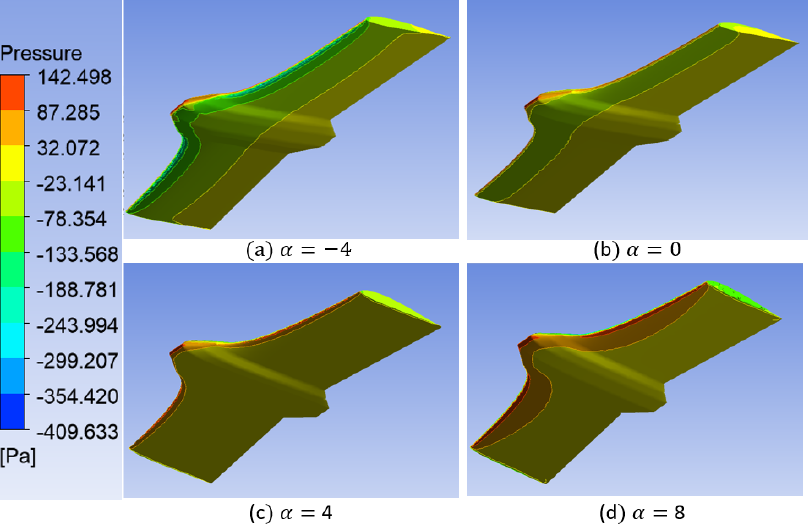
Figure 17. Pressure distribution on the tail-sitter surface at different angles of attack at lower surface. The inverse of the pressure behaviors around the tail-sitter area is observed in Figure 18a–c for the velocity distributions. When the aircraft is tilted downwards, the airflow is intercepted by the upper surface (extrados), causing a decrease in the air velocity and, consequently, an increase on the lower surface. The air velocity remains almost in balance at approximately 18 [m/s] on both sides when the angle of attack approaches zero, and when the angle of attack starts to increase (see the velocity contours when α = 4 and α = 8), the air velocity decreases on the intrados by up to 10 [m/s] and increases on the extrados by up to 23.3 [m/s], allowing for a better lift of the aircraft. In addition, the air velocity decreases progressively along the mid-span from root to tip. This avoids a greater wake effect at the